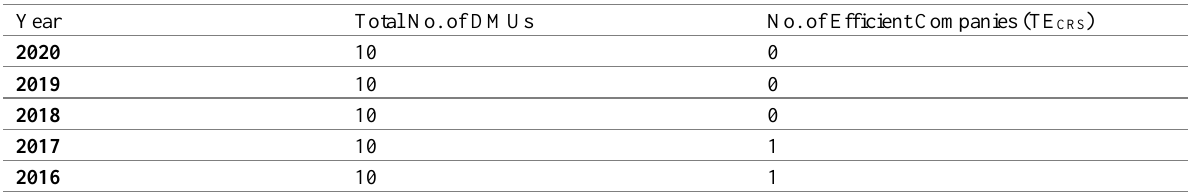
Table 5: Efficient Companies in